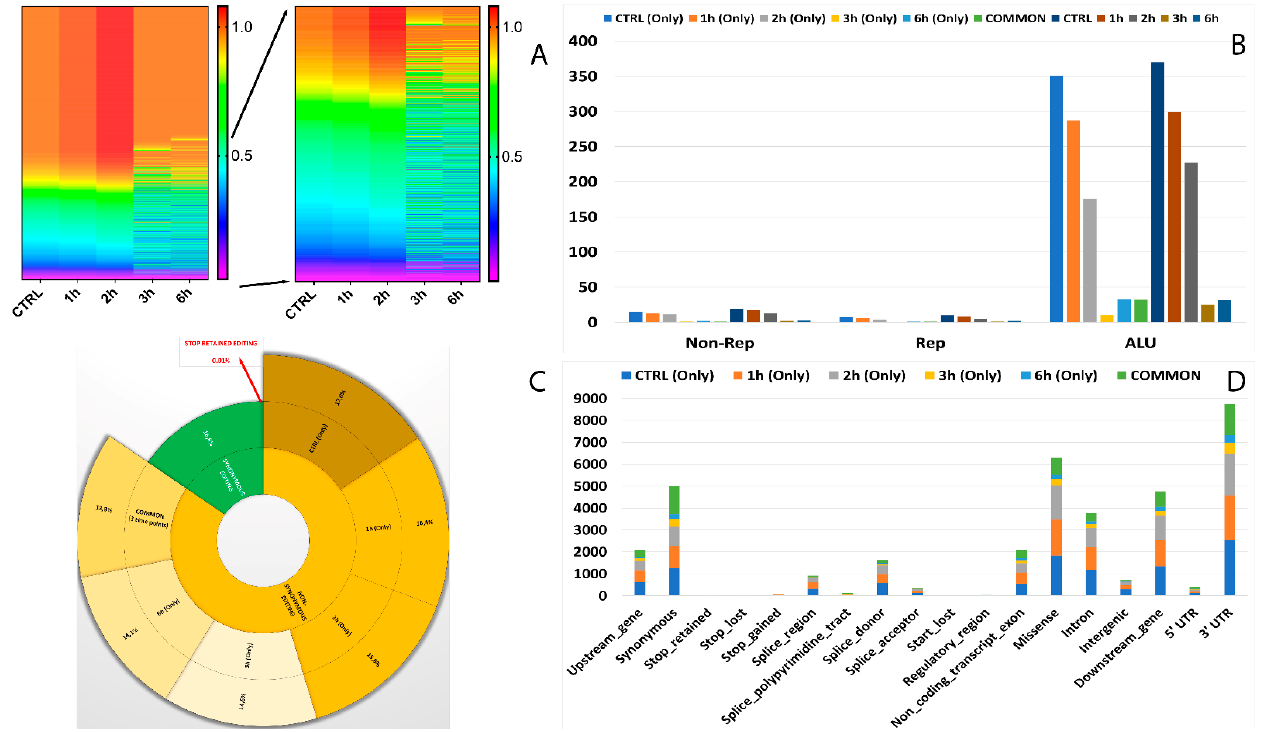
Figure 6. Editome de novo signatures during A2E exposure. ( A ) A heat map of the editing frequency from de novo sites that are particularly edited across A2E treatment. The color (from purple to red) indicates the editing frequency (from 0 to 1) for a given site (row) in a specific time point (column). The sub-heat map on the right underlines only the sites which changed during the treatment. ( B ) The proportion of de novo editing sites within ALU sequences, other repetitive elements, and outside SINEs across different time points. ( C ) The proportion of non-synonymous shift in coding region affected by de novo editing sites. ( D ) The distribution of de novo editing sites across different genomic elements. Syn. = Synonymous. Non-Syn. = Non-Synonymous. Stop Ret. = Stop Retained. Comm. = Common. TPs = Time